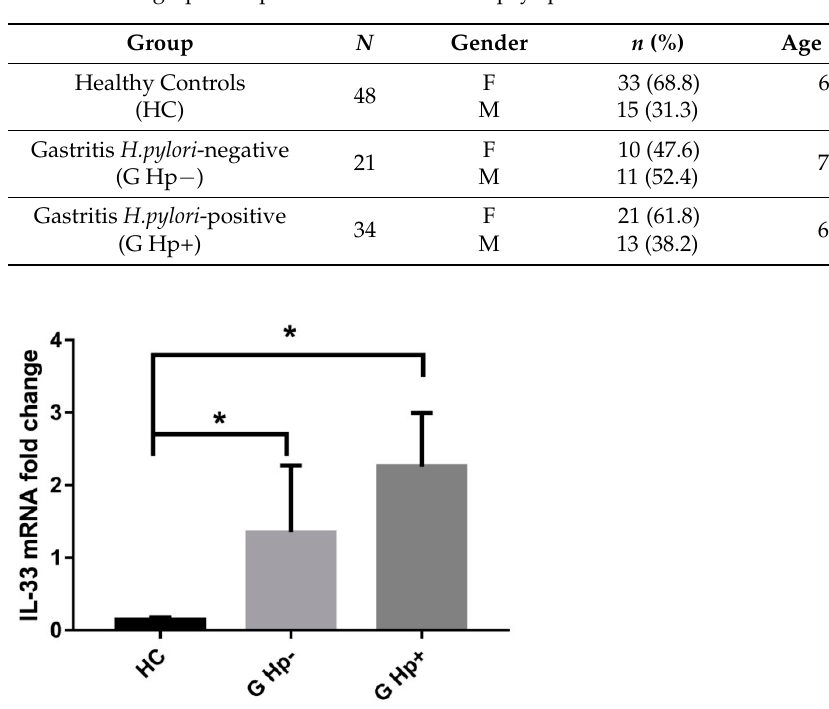
Table 1. Demographic of patients enrolled for biopsy specimen collection.